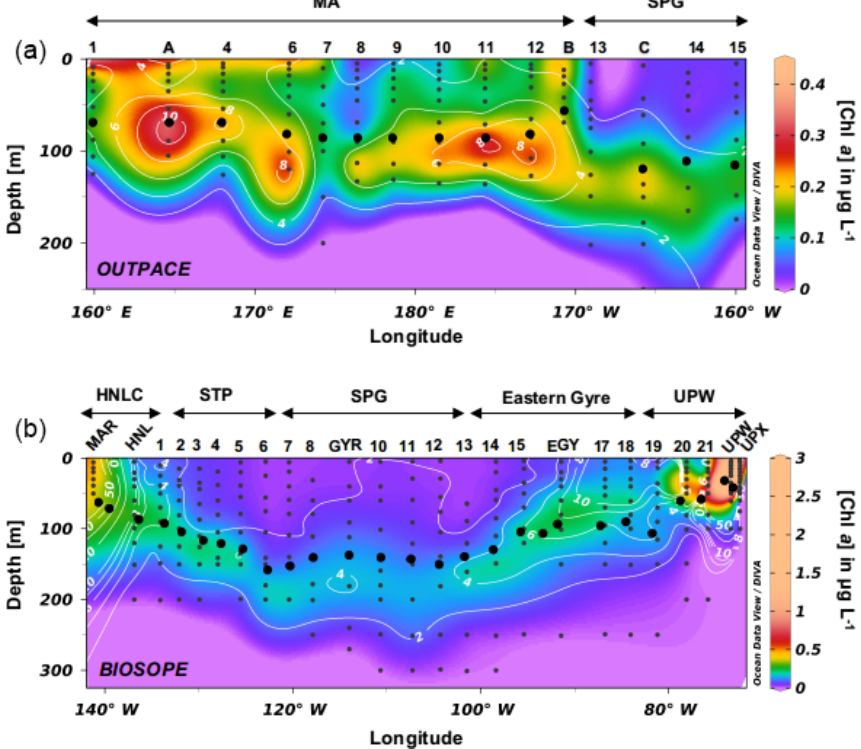
Figure 4. (a) TChl a distribution during the OUTPACE cruise in the southwestern Pacific (in µgL − 1 ) with fucoxanthin overlay lines in white (in ngL − 1 ). (b) TChl a distribution during the BIOSOPE cruise in the southwestern Pacific (in µgL − 1 ) with fucoxanthin overlay lines in white (in ngL − 1 ). Black dots indicate the Z e